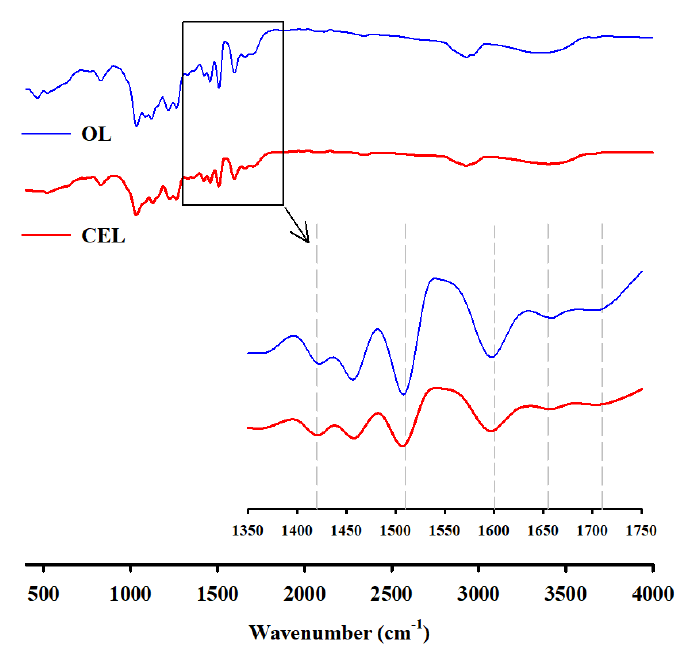
Figure 2. FTIR spectra of OL and CEL.